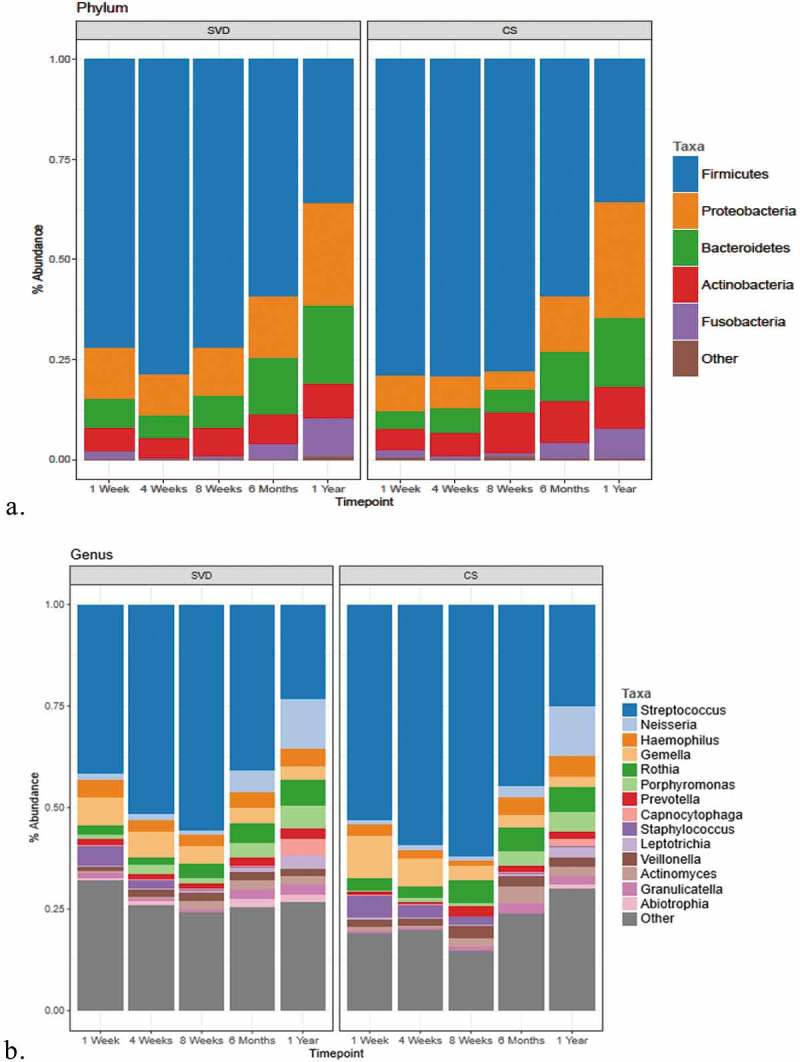
Comparison of the microbiota composition of infants born by different birth modes (SVD and CS) across five time points from 1 week to 1 year of age.(a) Microbiota composition at the phylum level. Percentages for each taxon represent the median abundance values for the sample types. (b) Bar plot of percentage abundance at the genus level. Percentages for each taxon represent the median values for the groups. The graph includes data for genera found at >1% average in the total population. Genera found at <1% were grouped as ‘other’.